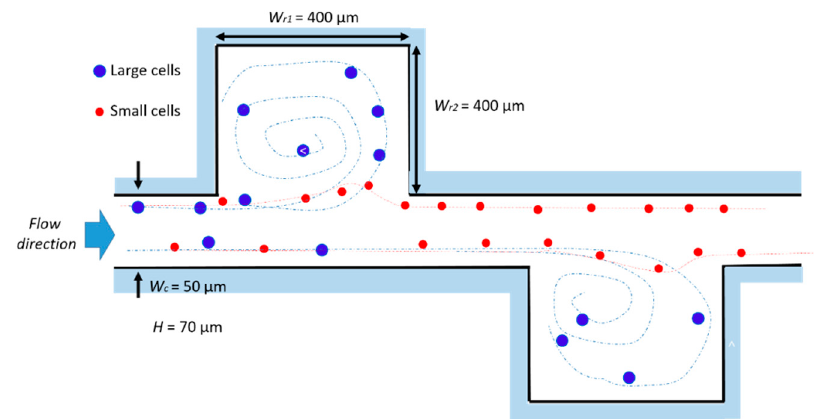
Figure 4. Design and working principle of the device of Hur et al. [56]. The larger cells remain trapped in the lateral chamber, while the smaller ones flow within the main channel, due to the dependence of the lift force on the particles’ dimension. Wr1 and Wr2 indicate the chamber dimensions, and Wc is the chamber width. All of the structures are 70 μ m high ( H ). The dashed paths indicate the fluid streamlines followed by the large (blue) and small (red) particles. Adapted from [62].